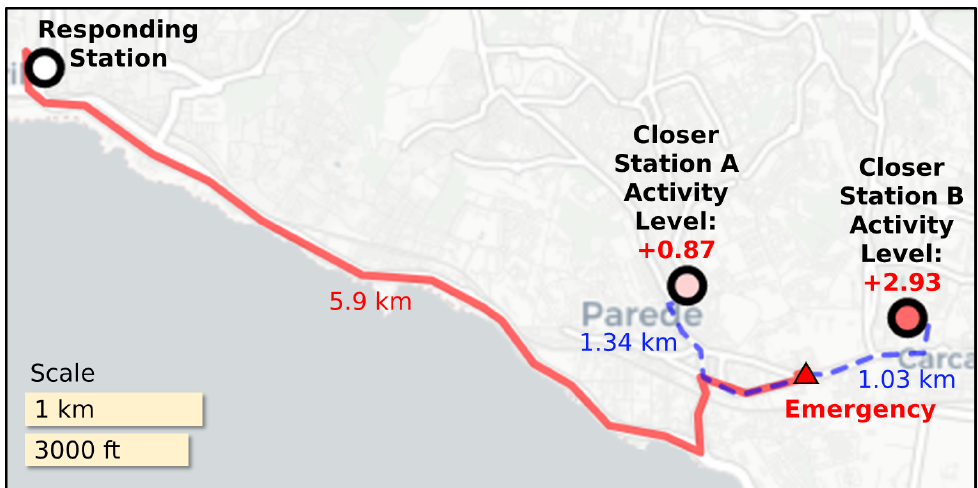
Figure 6. Example of a potential inefficiency where the two closer stations are busier than usual in the past 2 h. Map and routes are based on